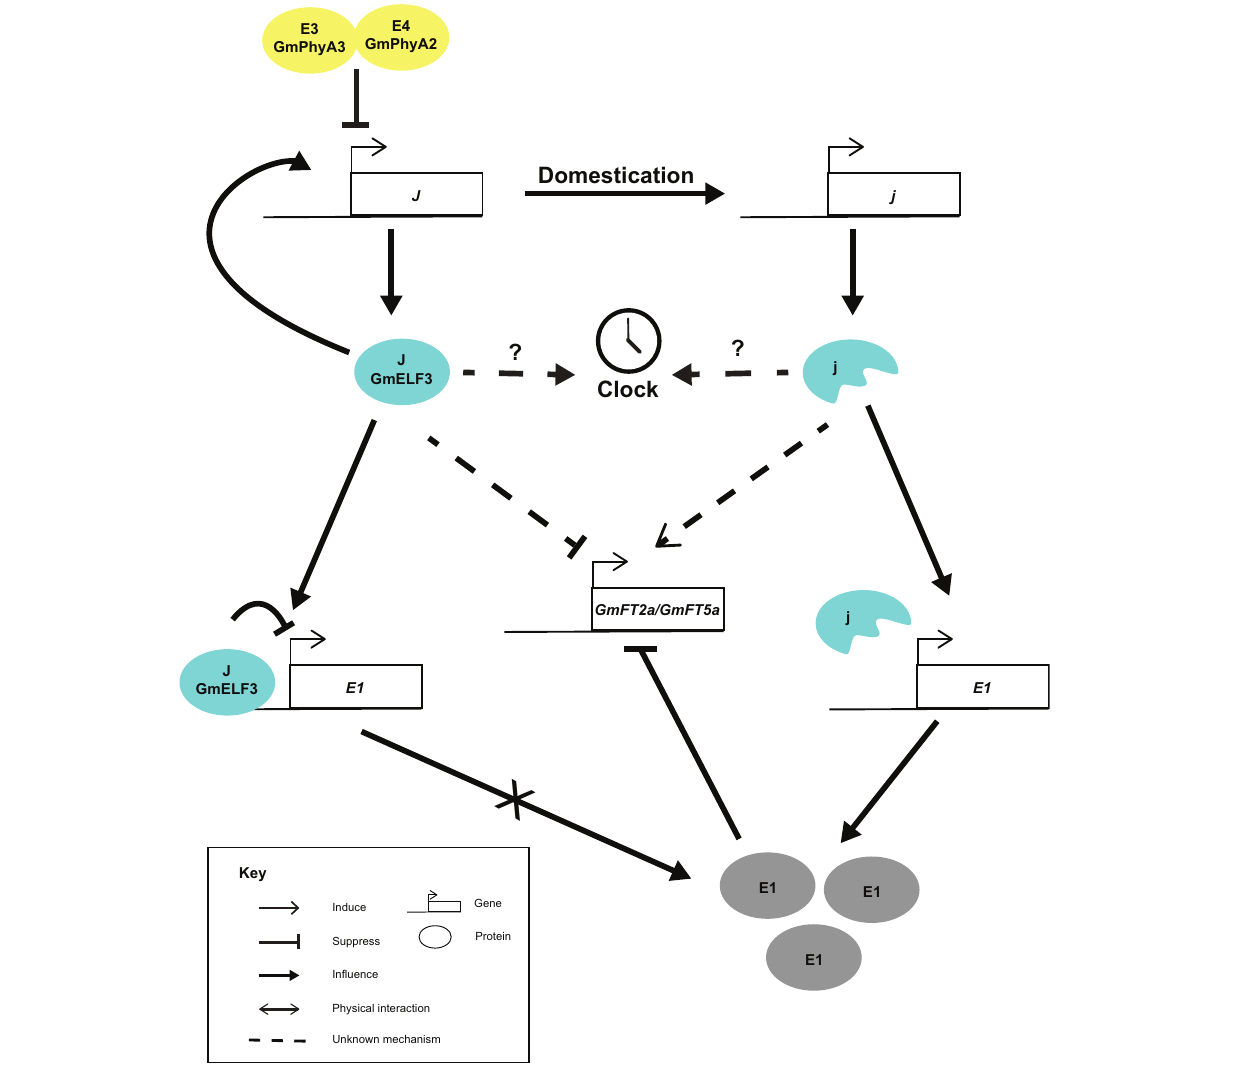
FIGURE 2 | Cartoon summarizing the known interactions of J . The J locus possibly perceive light signal through E3 and E4 loci. The J locus encodes GmELF3 (J), which auto-regulates its own expression. GmELF3 can directly acts on E1 promoter and suppress its expression. Without E1 expression under short day conditions, GmFT2a and GmFT5a are highly induced and lead to unproductive flowering. In the opposite, domestication has selected j alleles in tropical regions. The j proteins are unable to auto-regulate its own expression and has no ability to bind to E1 . Under this circumstance, E1 proteins are produced and suppresses the expression of GmFT2a and GmFT5a promoter under short day conditions which lead to the long juvenile phenotype.